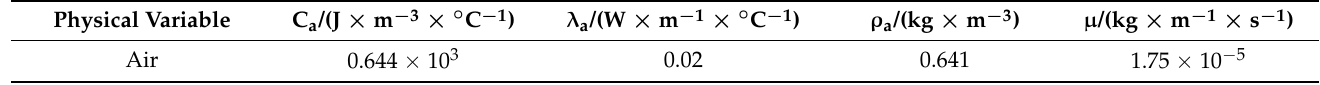
Figure 6. Physical model of the CRE with the CRL. Table 2. Physical parameters of the air.